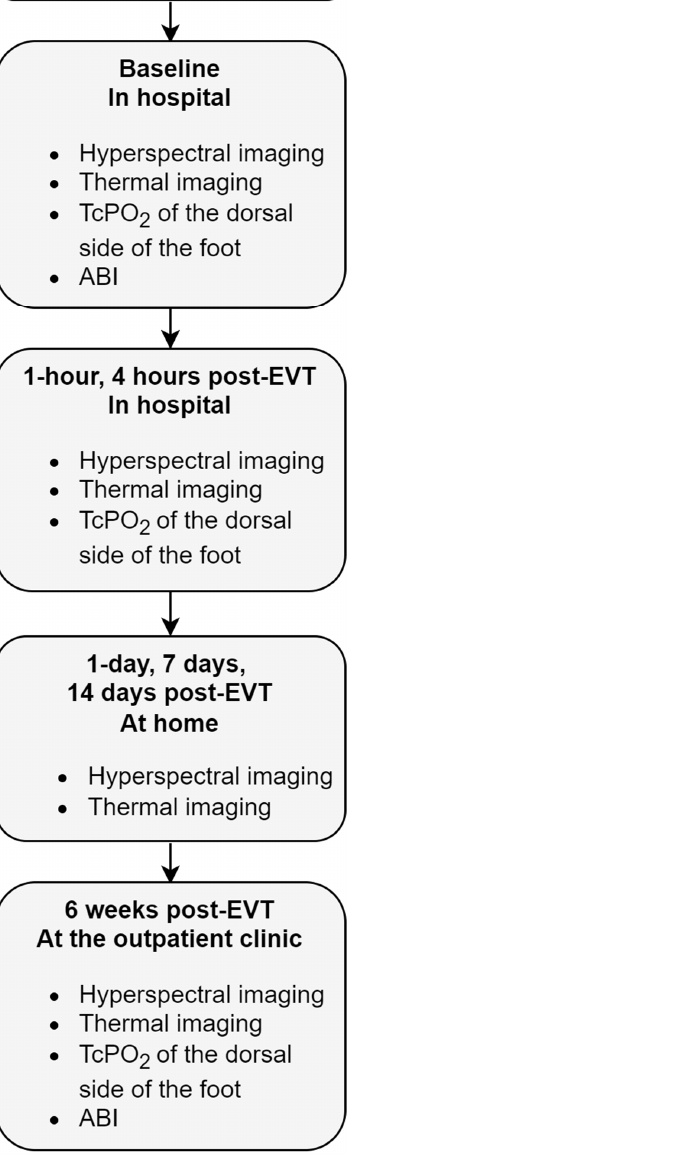
Figure 1. Flowchart of the measurement protocol. ABI, ankle-brachial index; EVT, endovascular therapy; TcP O 2 , transcutaneous oxygen pressure